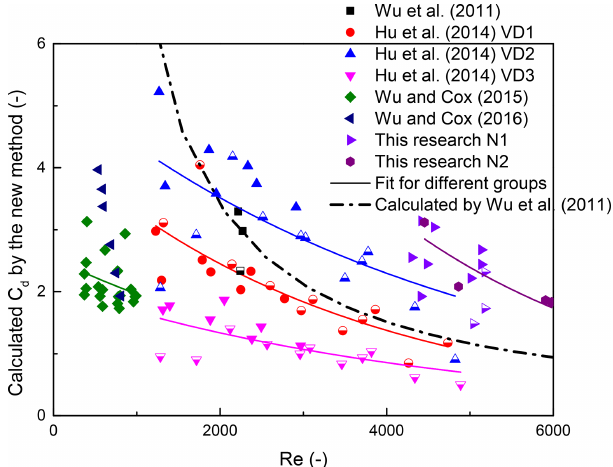
Figure 7. Relation between Re and C D by the new method. Dif- ferent symbols indicate cases from different research studies, and partially and fully solid symbols denote submerged and emerged cases, respectively. The solid lines following groups of the symbols indicate nonlinear fit by Eq.